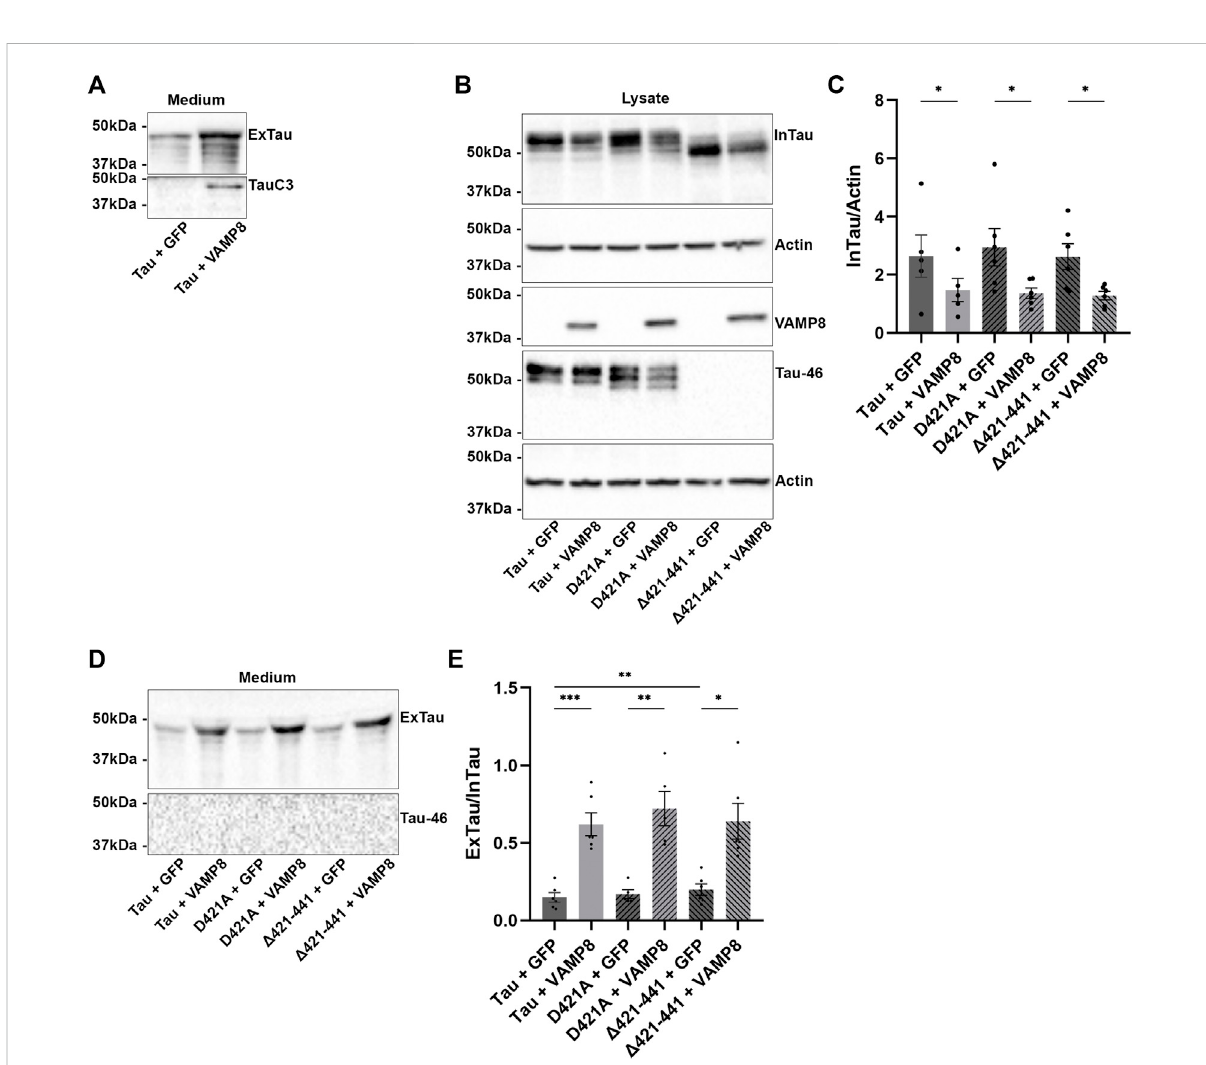
FIGURE 2 Secretion of Tau upon VAMP8 overexpression does not depend on the cleavage of Tau by caspase-3. N2a cells were transfected either with Flag-Tau and GFP-empty, Flag-Tau and GFP-VAMP8, TauD421A and GFP-empty, TauD421A and GFP-VAMP8, Tau Δ 421-441 and GFP-empty or Tau Δ 421-441andGFP-VAMP8plasmidsfor 48 h. (A) RepresentativeWesternblotwithTauC3antibodyofthemediumshowingthedetection ofTau cleaved by caspase-3 only detectable with VAMP8 overexpression. (B) Representative Western blot with A0024 of the cell lysate showing that the overexpression of VAMP8 decreased intracellular Tau (InTau) of all Tau mutants. (C) Densitometry analysis of A0024 signal of InTau. n = 6. Data represent scatter plot and mean±SEM. * p < 0.05. (D) Representative Western blot with A0024 of the medium showing that the overexpression of VAMP8 increased extracellular Tau (ExTau) of all Tau mutants. (E) Densitometry analysis of A0024 signal of the ExTau/InTau ratio. n = 6. Data represent scatter plot and mean±SEM. * p < 0.05, ** p < 0.01, *** p <